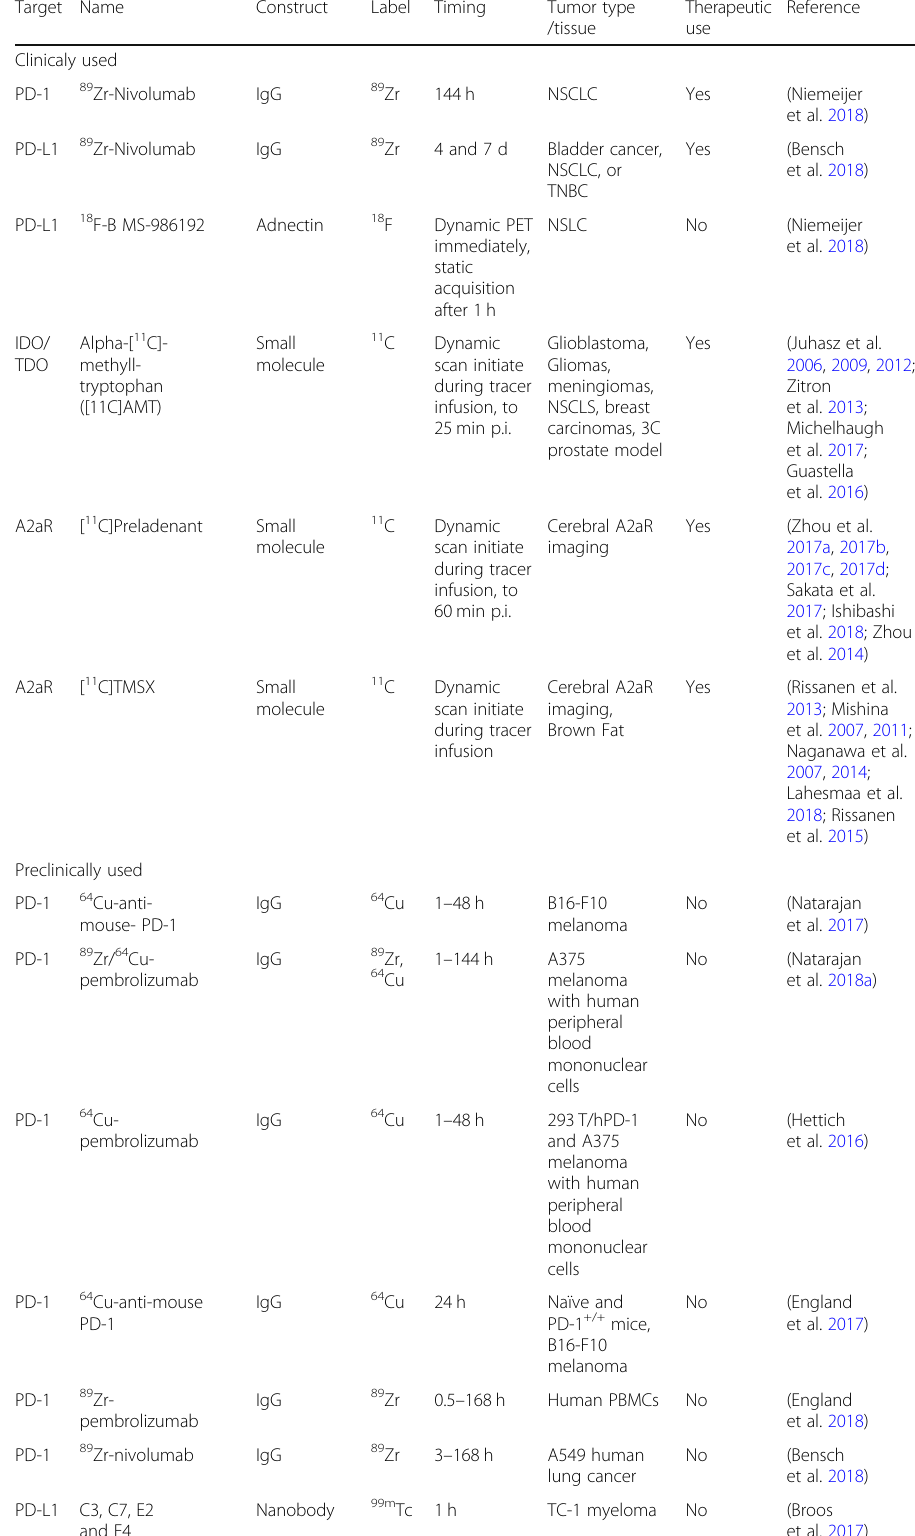
Table 1 Overview of nuclear imaging tracers for immune checkpoints. Only tracers that have been published and used in at least preclinical in vivo studies are described in the tables